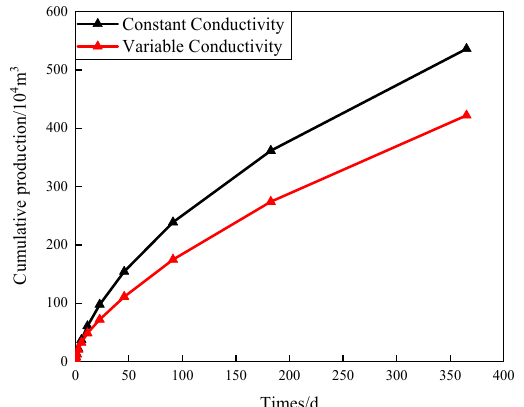
Figure 12. Cumulative production (constant conductivity vs. variable conductivity).